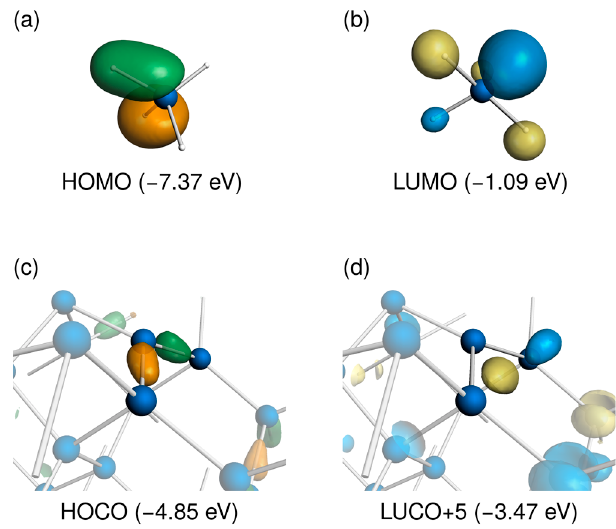
Figure 3. Top: HOMO ( a ) and LUMO ( b ) of an asymmetrically-distorted silane molecule (two Si–H bonds deflected by α = 30 and 50°, respectively), representing the coordination of a Si sub atom on a Si(001) surface (see Figure 1b). Bottom: HOCO ( c ) and LUCO+5 ( d ) of a Si(001) surface slab at the Γ point in k space, showing a similar electronic structure at the Si sub atoms.